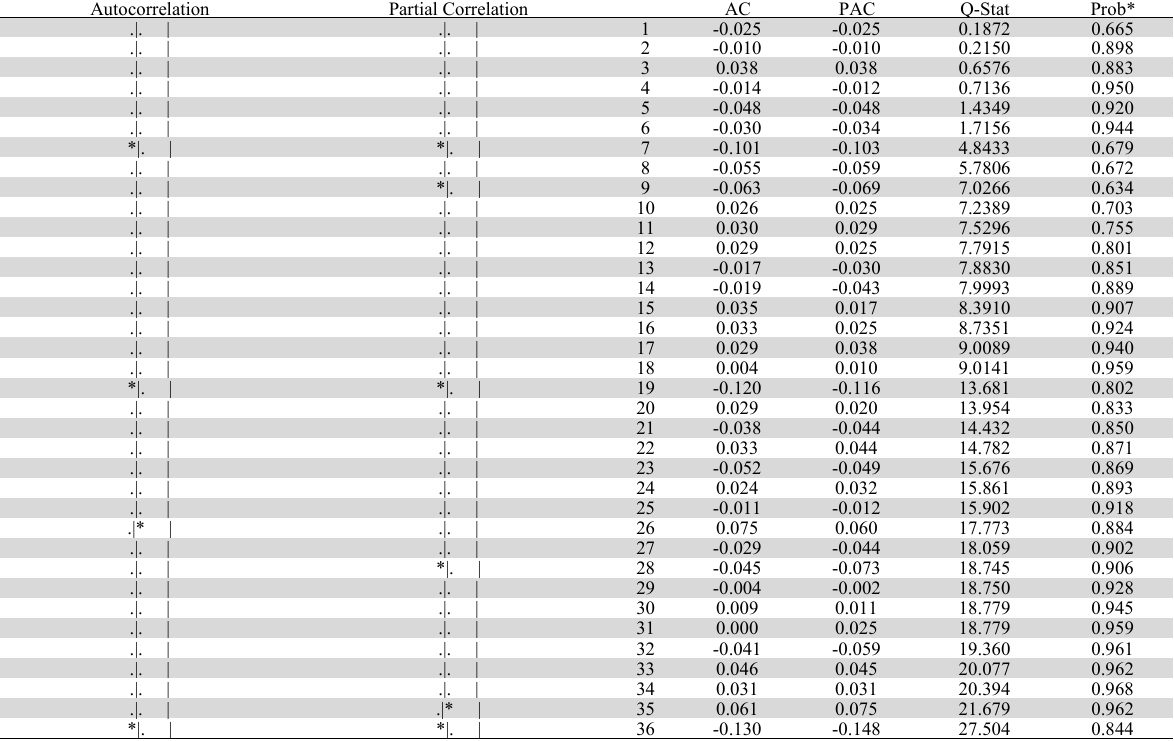
Exhibit the Post Estimation Model Output of Residual Diagnostics Correlogram Q- Statistics Autocorrelation Partial Correlation